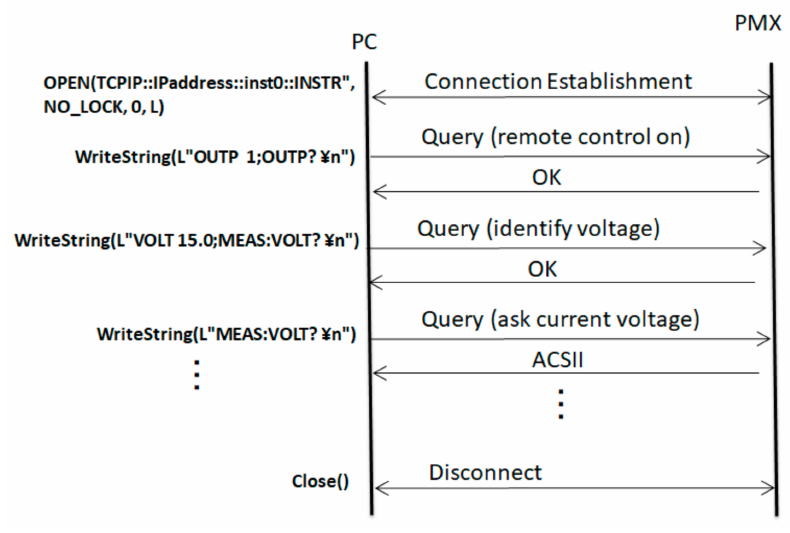
Figure 7. Asynchronous communication using the VISA standards.